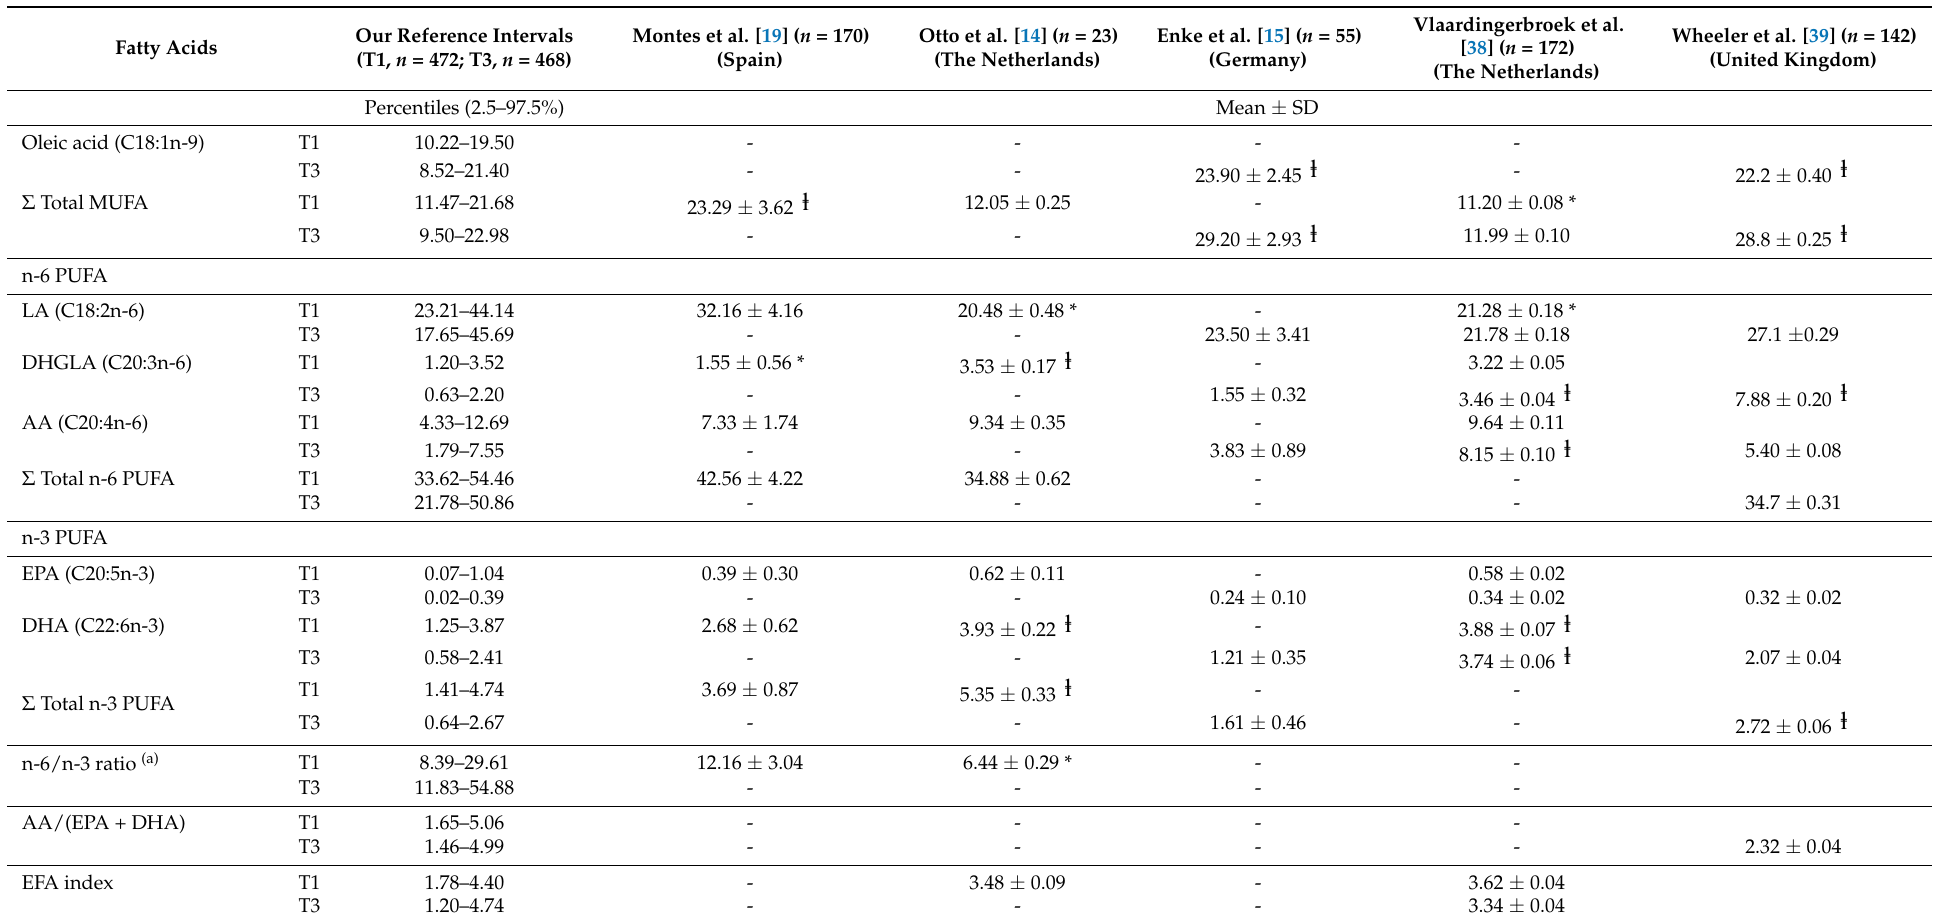
Table 5. Multiple linear regression of potential factors related to maternal serum fatty acids composition in the first (T1) and third (T3) trimesters of pregnancy. T1: First Trimester of pregnancy; T3: Third trimester of pregnancy. LA, Linoleic acid; DHGLA, Dihomo- γ -linolenic